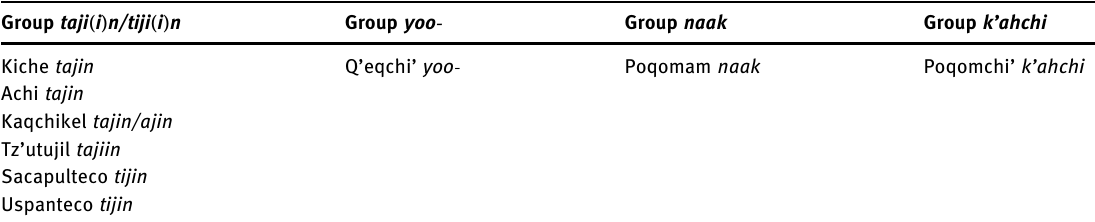
Table 4: Aspectual predicates in K ’ iche ’ an